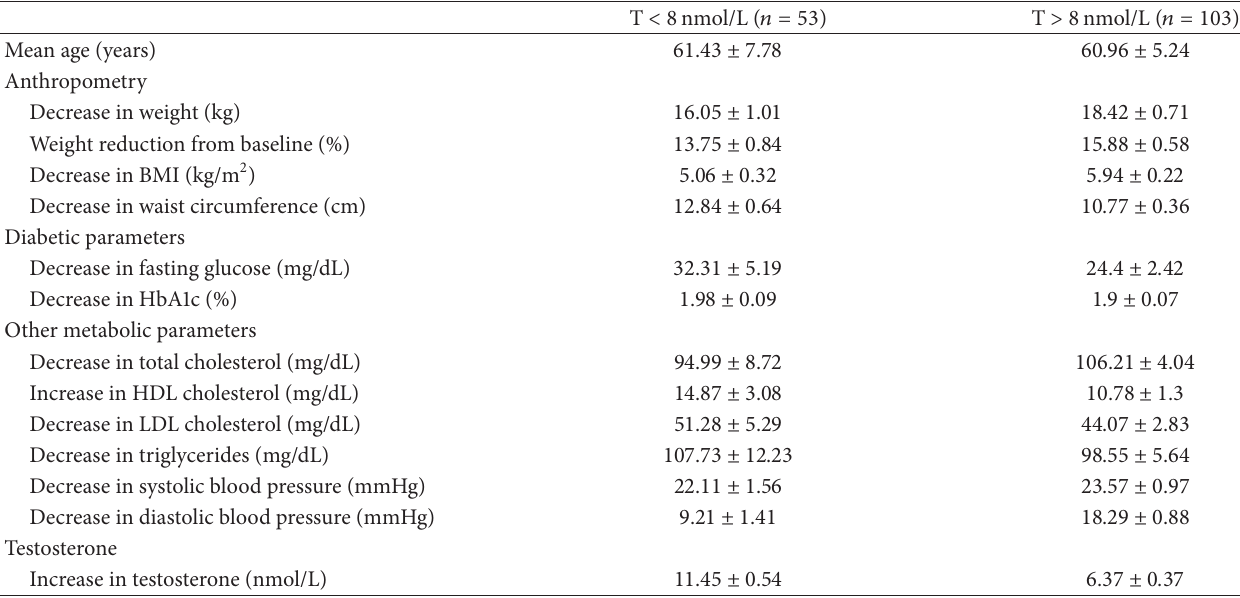
Table 3: Changes in anthropometric and metabolic parameters in subgroups of obese hypogonadal men with type 2 diabetes and total testosterone < 8 nmol/L versus total testosterone > 8nmol/L and < 12nmol/L after treatment with testosterone undecanoate for up to 6